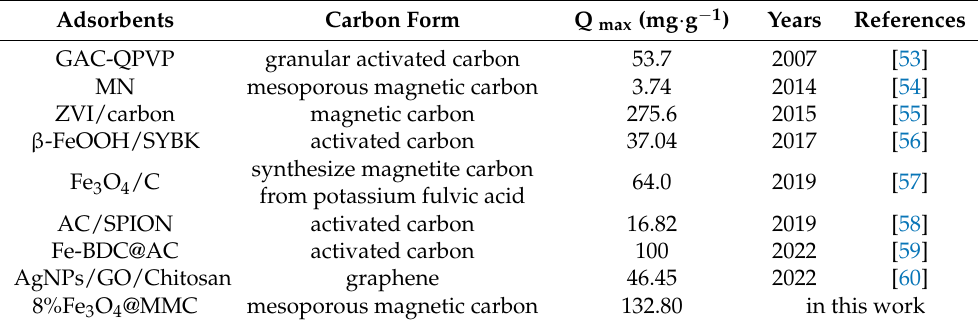
Table 8. Comparison of adsorption capacity for Cr(VI) ions in water